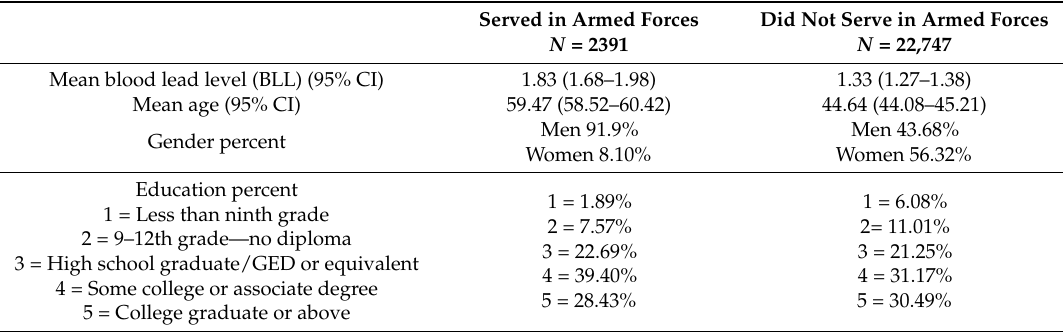
Table 1. Sociodemographic and clinical markers in the